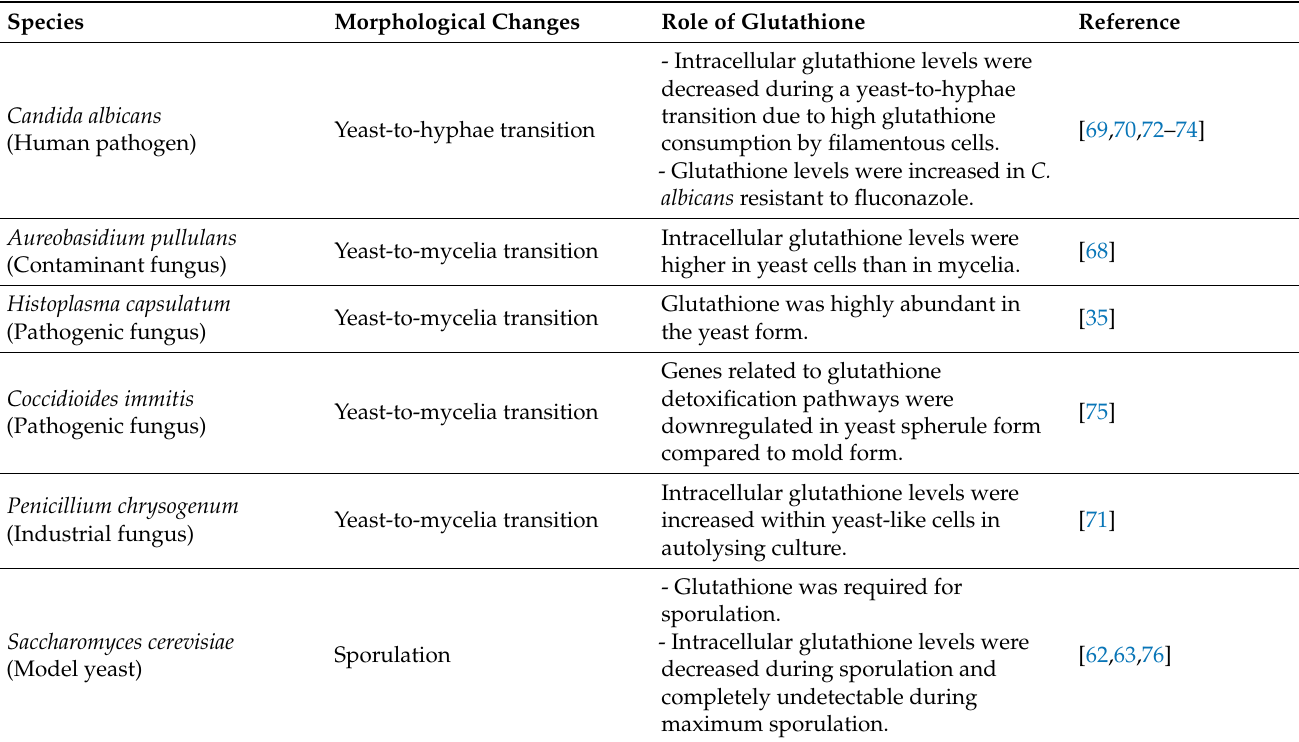
Table 2. Role of glutathione levels in fungal cellular